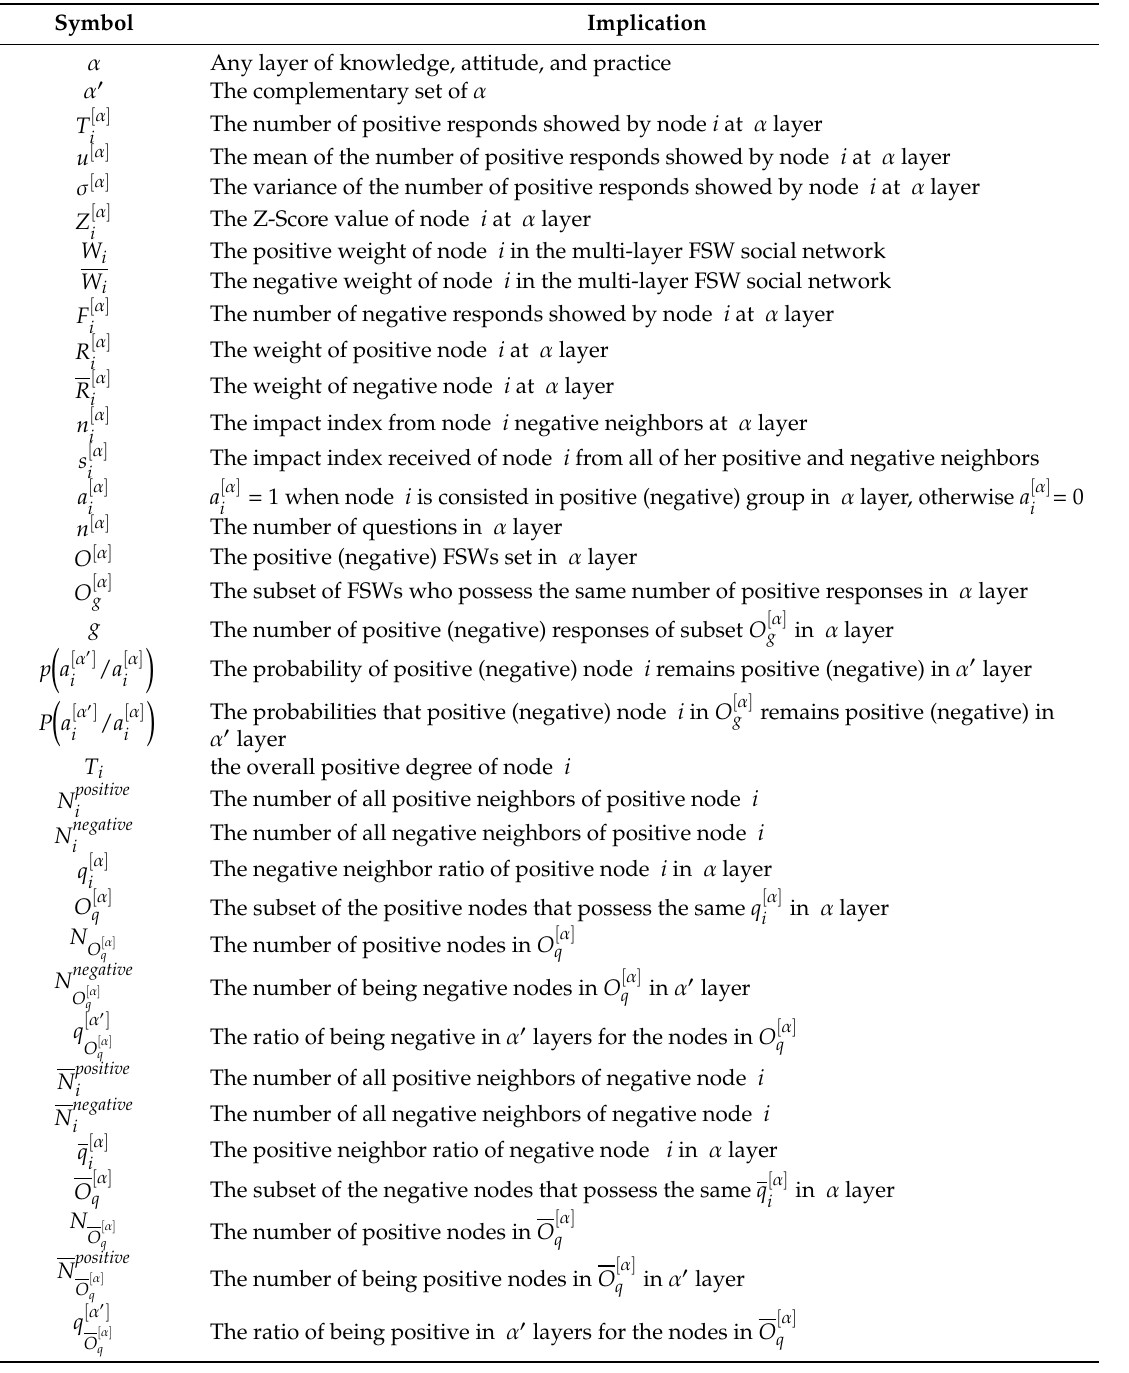
Table A5. Symbols and related